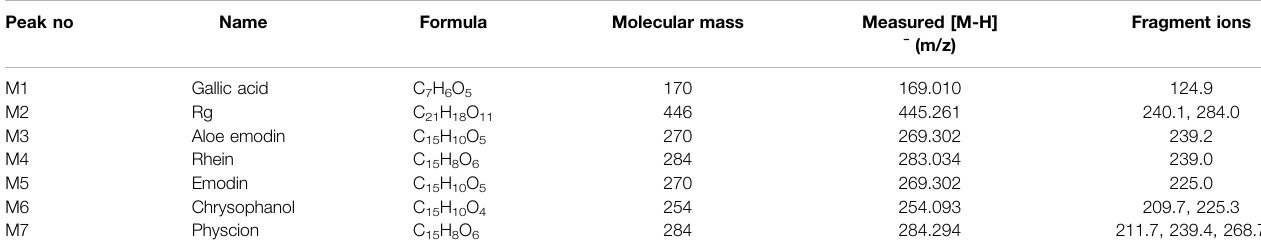
TABLE 1 | Typical MS data of major compounds in SR